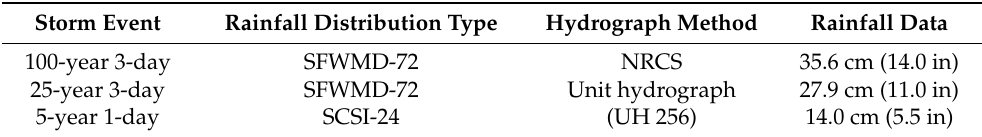
Table 5. Summary of the design storm simulation parameter input data.